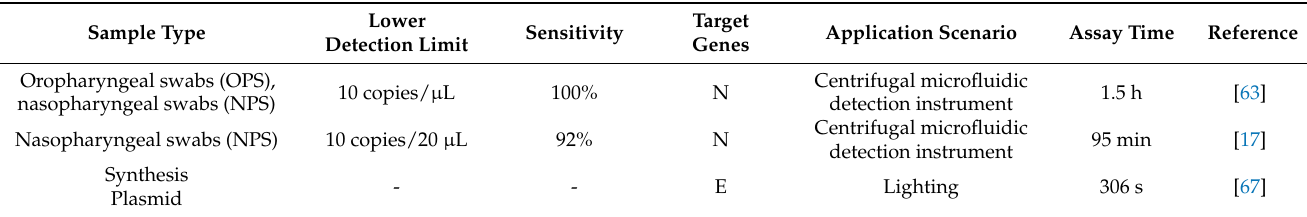
Table 4. The data and applications of on-chip PCR detection technology were